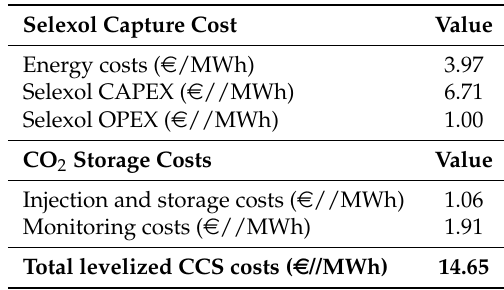
Table 10. Levelized costs for the reference scenario (electricity generation setup) in terms of onshore Selexol capture, injection, storage, and monitoring considering an emission rate of 2.2 t CO 2 /t